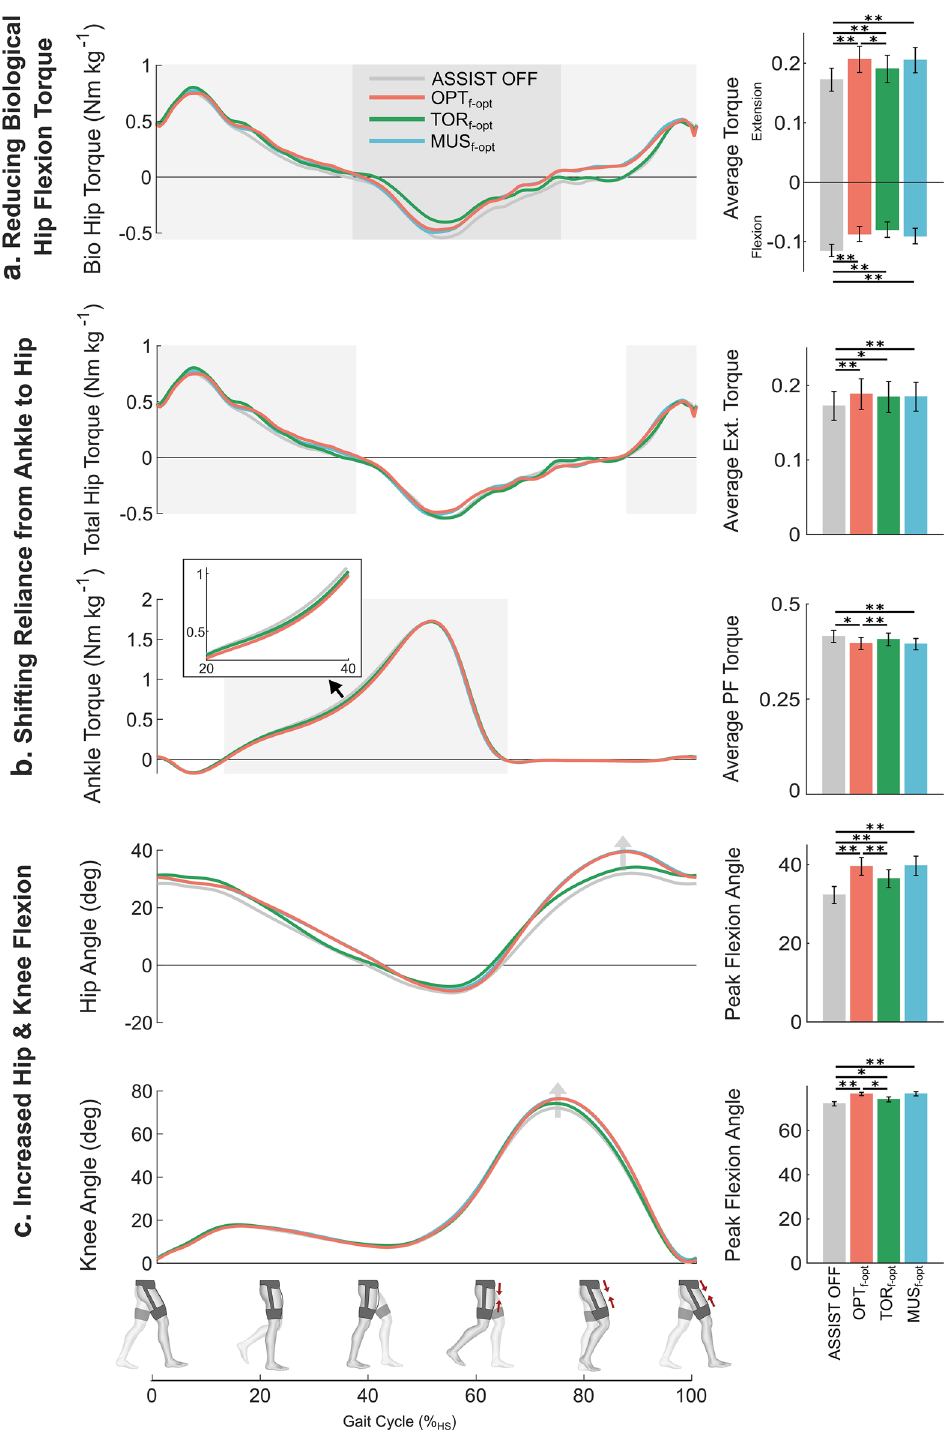
Figure 5. Biomechanics effects of assistance timing. Comparison between ASSIST OFF and three different actuation timings at the same assistance magnitude ( f − opt ). Three conditions were individualized timing resulting from HIL ( OPT f − opt ), biological torque inspired timing ( TOR f − opt ) and biological muscle inspired timing ( MUS f − opt ). ( a ) (left) Biological hip torque over the gait cycle. (right) Average biological hip flexion and extension torque. ( b ) (left) Total hip extension and ankle plantarflexion torque over the gait cycle. (right) Average total hip extension torque and average ankle plantarflexion torque. ( c ) (left) Hip and knee joint angles across the gait cycle. (right) Peak hip flexion and peak knee flexion angle. Shaded regions indicate areas of analysis. Error bars indicate the standard error of the mean (SEM). Asterisks indicate statistically significant differences (n = 8, two-sided paired t tests; * P < 0.05; ** P <